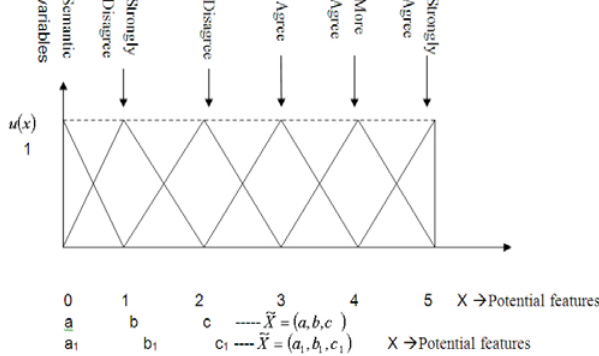
Figure 3: The membership function figure of five-level semantic variables Semantic terms